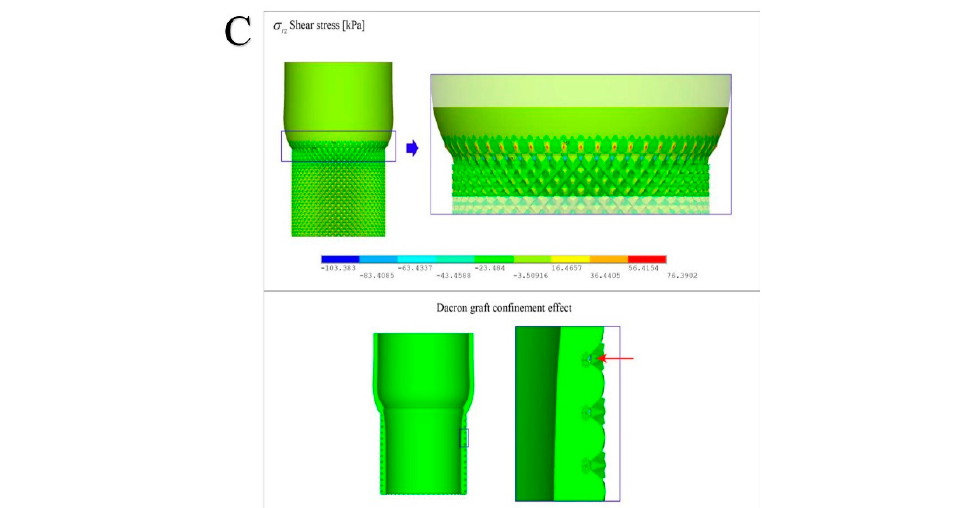
Figure 3. Geometry and the mechanical features of the native aorta and the native pulmonary artery ( A ) and the pulmonary autograft ( B ). ( C ) Illustration of the spurious shear stresses in the suture zone (Top), and the Dacron structure confinement acting on the pulmonary autograft (PA) pressurized vessel (Bottom).